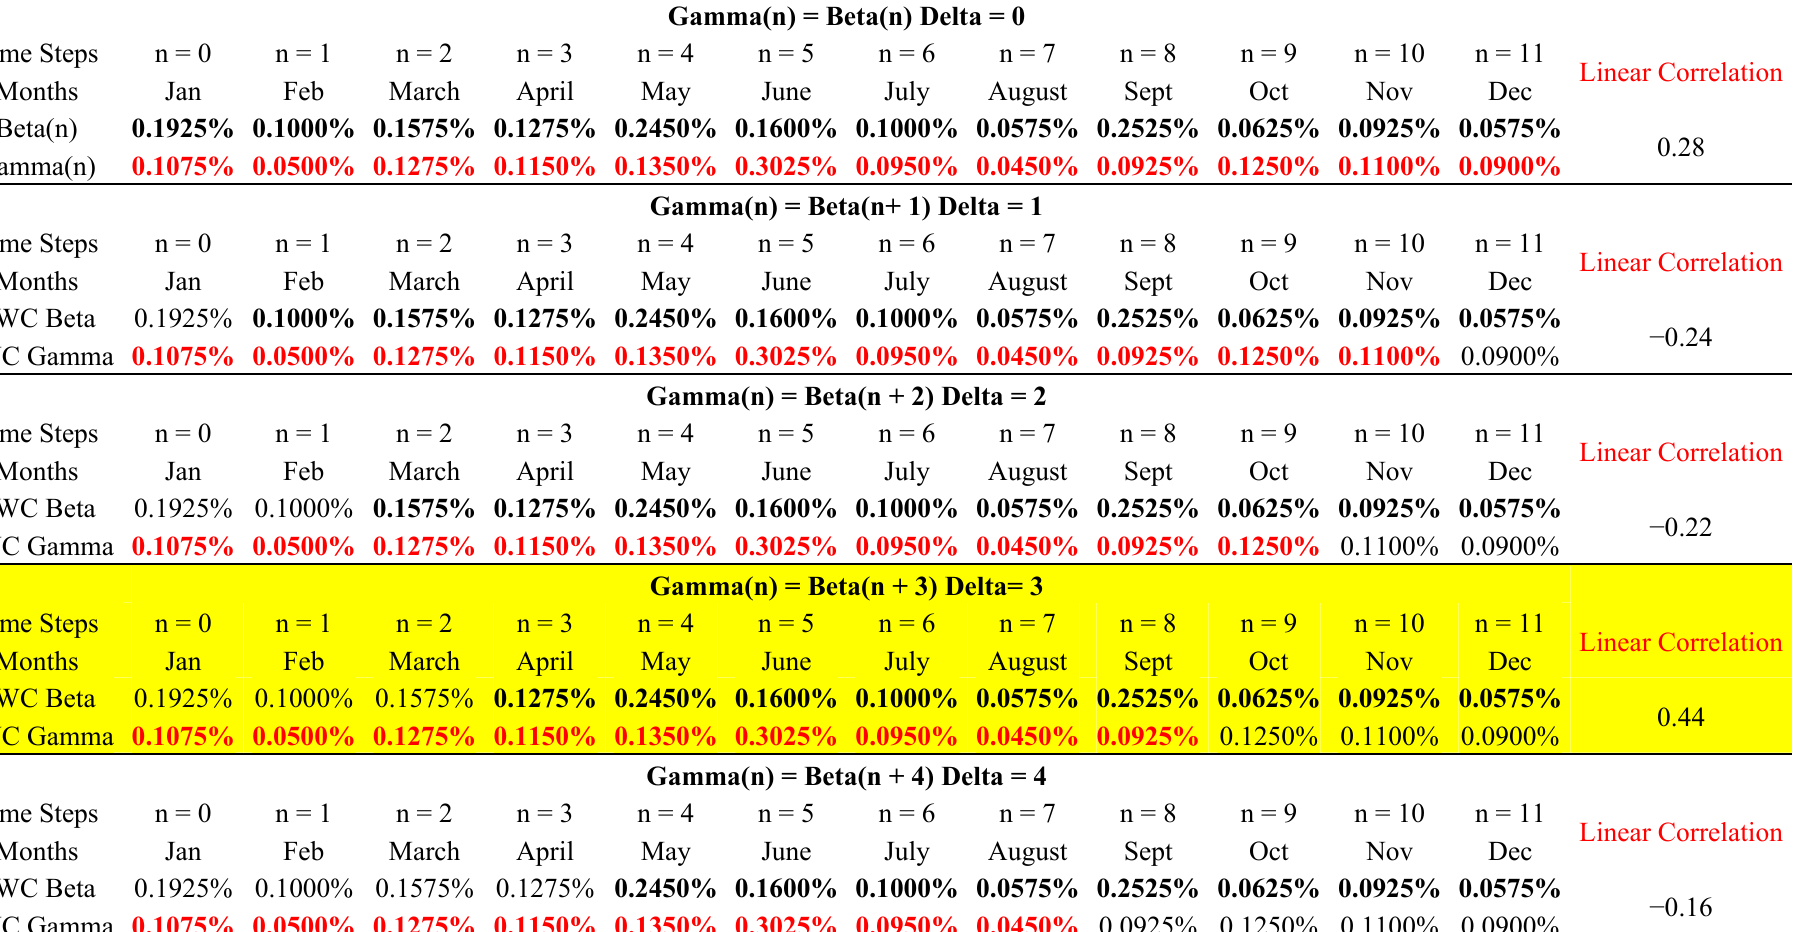
Table 12. Predictive correlation between TWC (Gamma) and TWC (Beta) with different